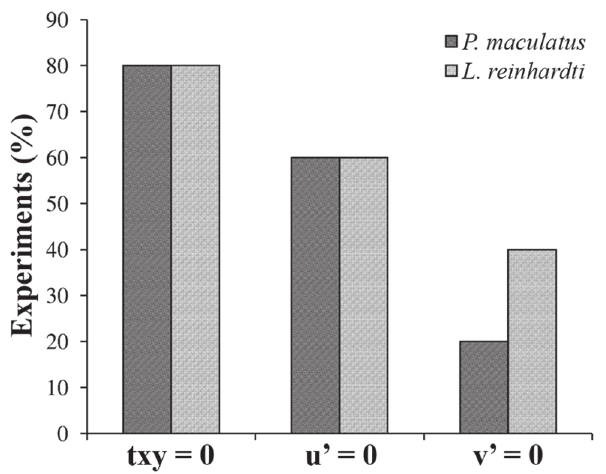
Fig. 7. The use (%) of areas with null Reynolds shear-stress on XY, null velocity fluctuation on X ( u ’) and null velocity fluctuation on Y ( v’ ).